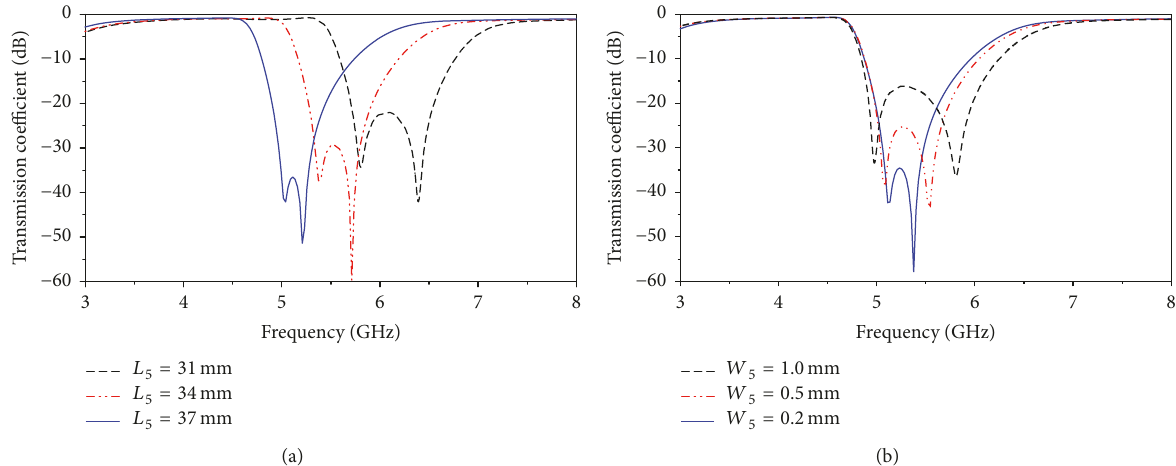
Figure 6: Frequency-dependent transmission coefficient of the proposed dual-mode triangular loop resonator loaded slotline against (a) 𝐿 5 and (b) 𝑊 5 .